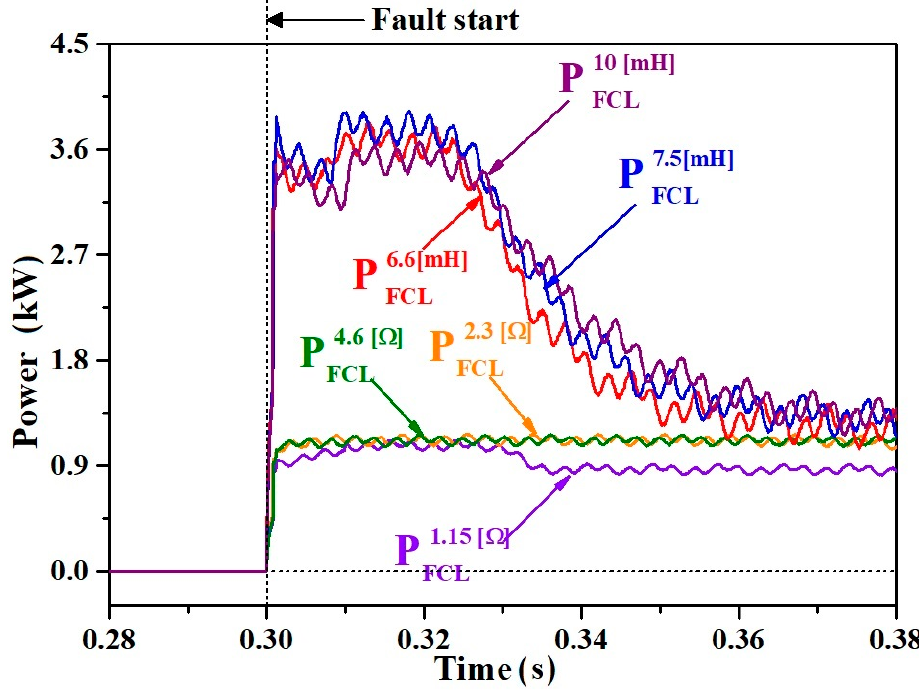
Figure 11. Comparative instantaneous power waveforms of the DC SFCL using a transformer Figure11. ComparativeinstantaneouspowerwaveformsoftheDCSFCLusingatransformerdependent dependent on the CLR’s component. on the CLR’s